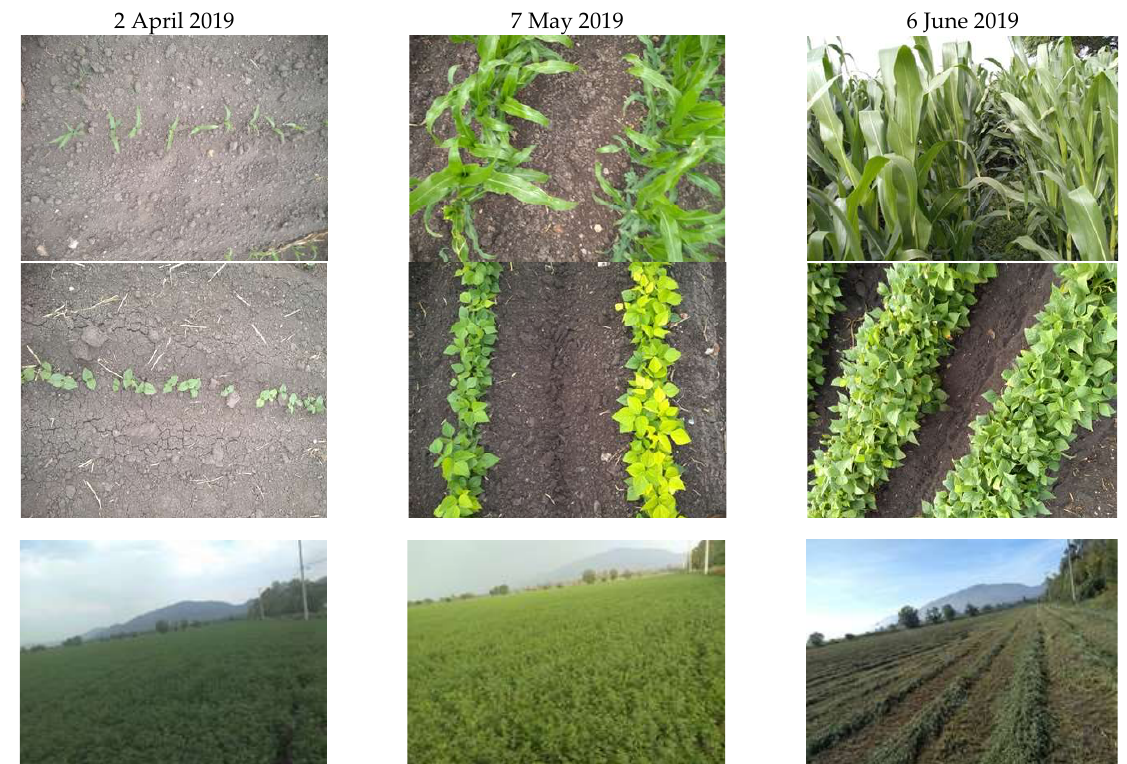
Figure 7. Temporal profiles of corn ( top ), beans ( center ) and alfalfa ( bottom ) over a period of 63 days (about 2 months).